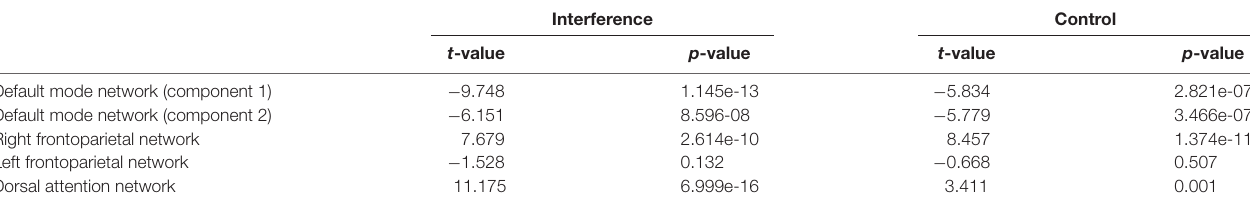
TABLE 1 | Network task relatedness across both age groups.